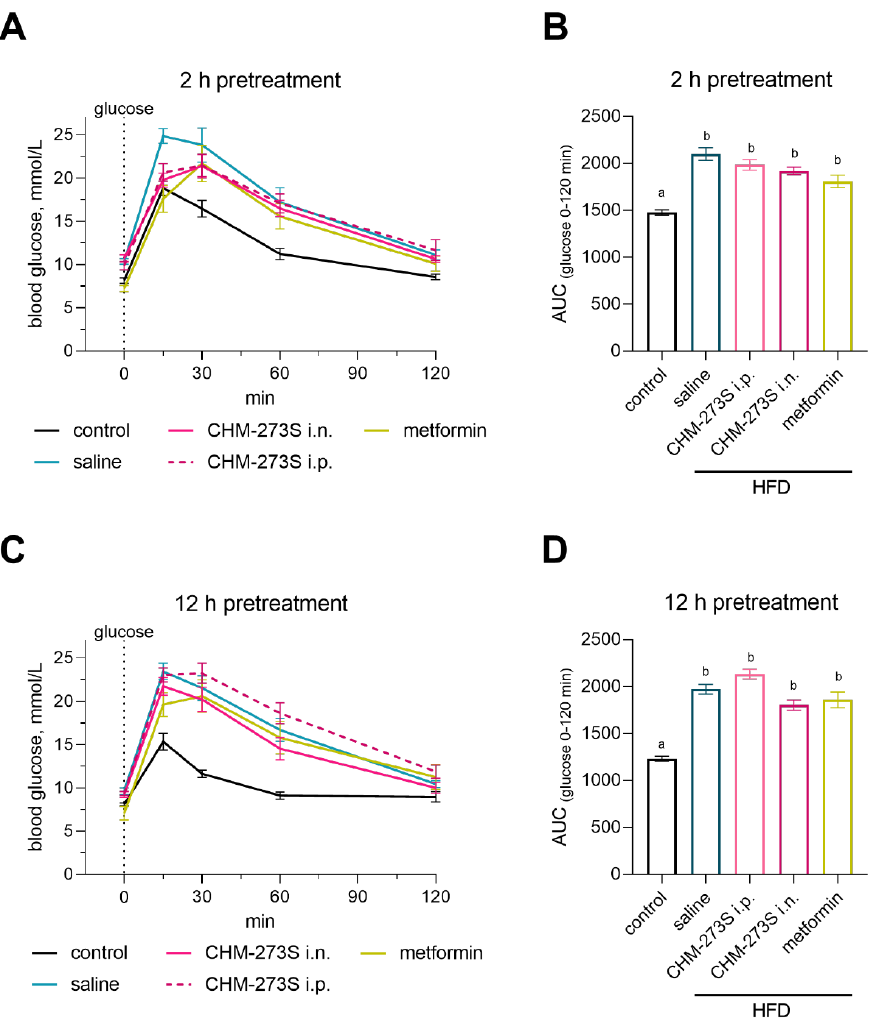
Figure 7. The effects of CHM-273S (5 mg/kg intraperitoneally (i.p.) or intranasally (i.n.), n = 12–13 each) and metformin (250 mg/kg perorally (p.o.), n = 12–13) pretreatment after 16 weeks of the high- fat diet (HFD) on the oral glucose tolerance test (OGTT) in mice. Blood glucose concentrations were measured by a glucometer after a 12 h fast at 0, 15, 30, 60, and 120 min following gavage with 2 g/kg of an oral glucose (40%) preload ( A ) 2 h or ( C ) 12 h after CHM-273S or metformin treatment. ( B , D ) The area under the curve (AUC) for the OGTT in HFD-fed mice after CHM-273S or metformin pre- treatment for 2 or 12 h. Compared with the control group, the blood glucose levels were significantly higher in the HFD-fed, saline-treated; HFD-fed, metformin-treated; and HFD-fed, CHM-273S- treated groups when the treatment was administered ( B ) 2 h (F (4,60) = 19.54, p < 0.0001) or ( D ) 12 h (F (4,60) = 34.23, p < 0.0001) before the OGTT. There was a significant reduction in blood glucose com- pared with HFD-fed, saline-treated mice in groups pretreated with i.n. CHM-273S or metformin 2 h before the OGTT (F (4,60) = 19.54, p < 0.0001). The results are presented as the mean ± standard error of the mean. Different superscript letters indicate significant differences at p < 0.05.; one-way analy- sis of variance with the Holm –Šídák multiple comparisons test. After the OGTT, mice were fed the HFD for another 5 weeks (21 weeks in total). From weeks 18 to 21, the animals received CHM-273S (i.n. or i.p.) or metformin (250 mg/kg p.o.).